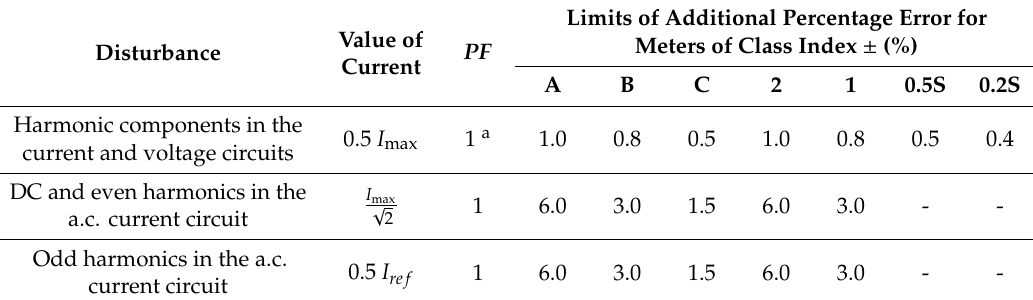
Table 3. Additional percentage error limits for the harmonic disturbance tests regarding the accuracy classes A, B, C (EN 50470-3) and 2, 1, 0.5S, 0.2S (IEC 62053-21, -22).